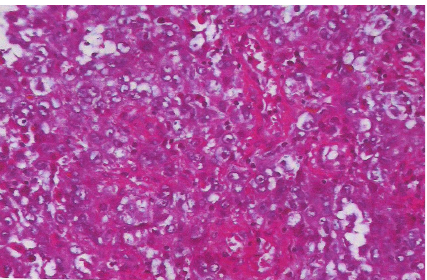
Figure 3: Focal positivity for KL1 type of anti-cytokeratin tumor cells in immunohistochemistry, anti-cytokeratin.